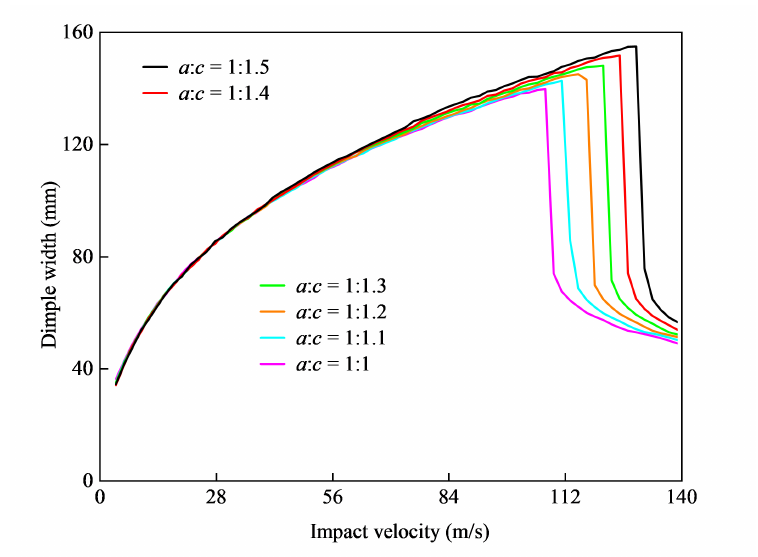
Figure 15. Dimple width changes with the increase in shell depth with a constant length of the a axis.